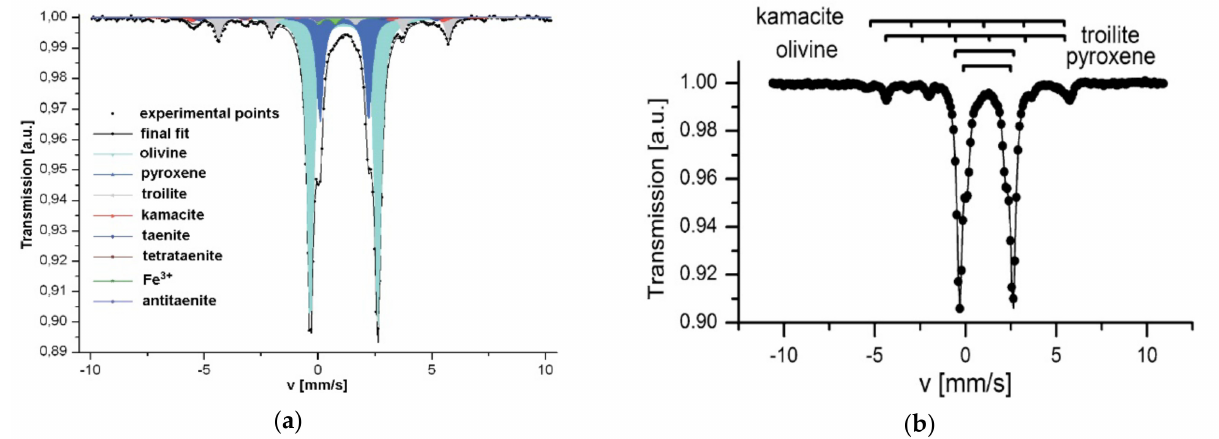
Figure 25. Room temperature Mössbauer spectra of equilibrated ordinary chondrite Shi¸sr 176 L6 measured in [93] ( a ) and in [94] ( b ). Indicated components are the results of the fits. Adapted from References